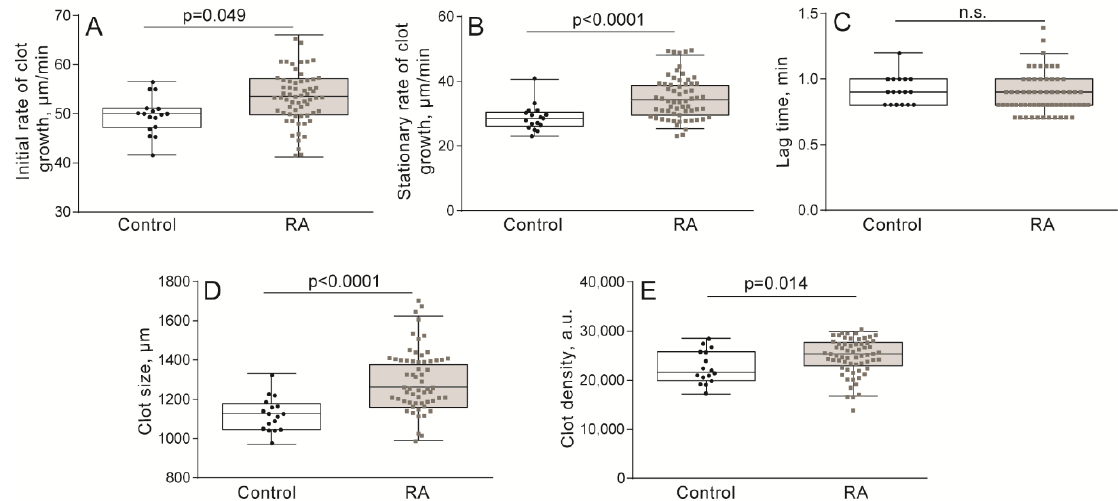
Figure 2. Parameters to quantify fibrin clot growth from Thrombodynamics measurements in patients with rheumatoid arthritis (RA) ( n = 60) compared with the control group ( n = 50). The initial growth rate of the clot ( A ), stationary growth rate of the clot ( B ), lag time ( C ), clot size ( D ), and clot density ( E ). The results are presented as the median and intervals between 25th and 75th, as well as between 5th and 95th percentiles (Mann-Whitney U test). n.s.—not significant.